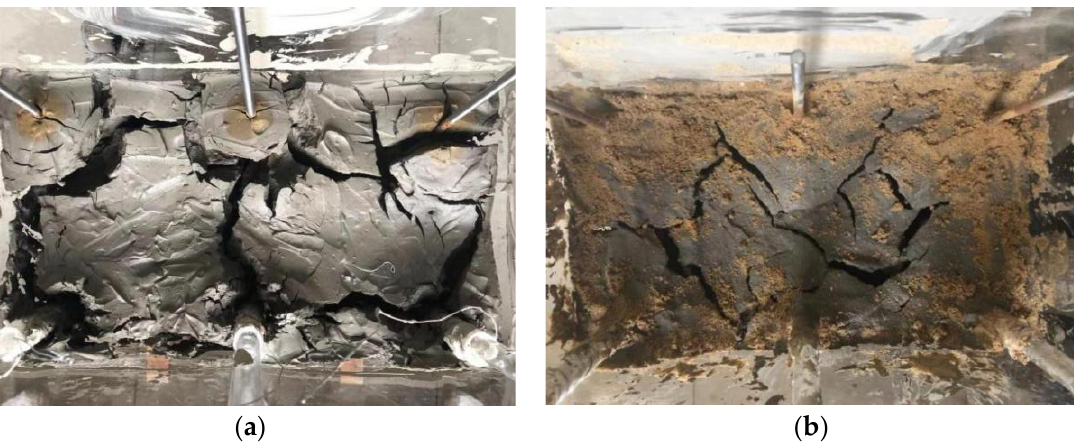
Figure 5. Soil cracks that developed during the tests: ( a ) The soil state after T1 test; ( b ) The soil state after T2 test.